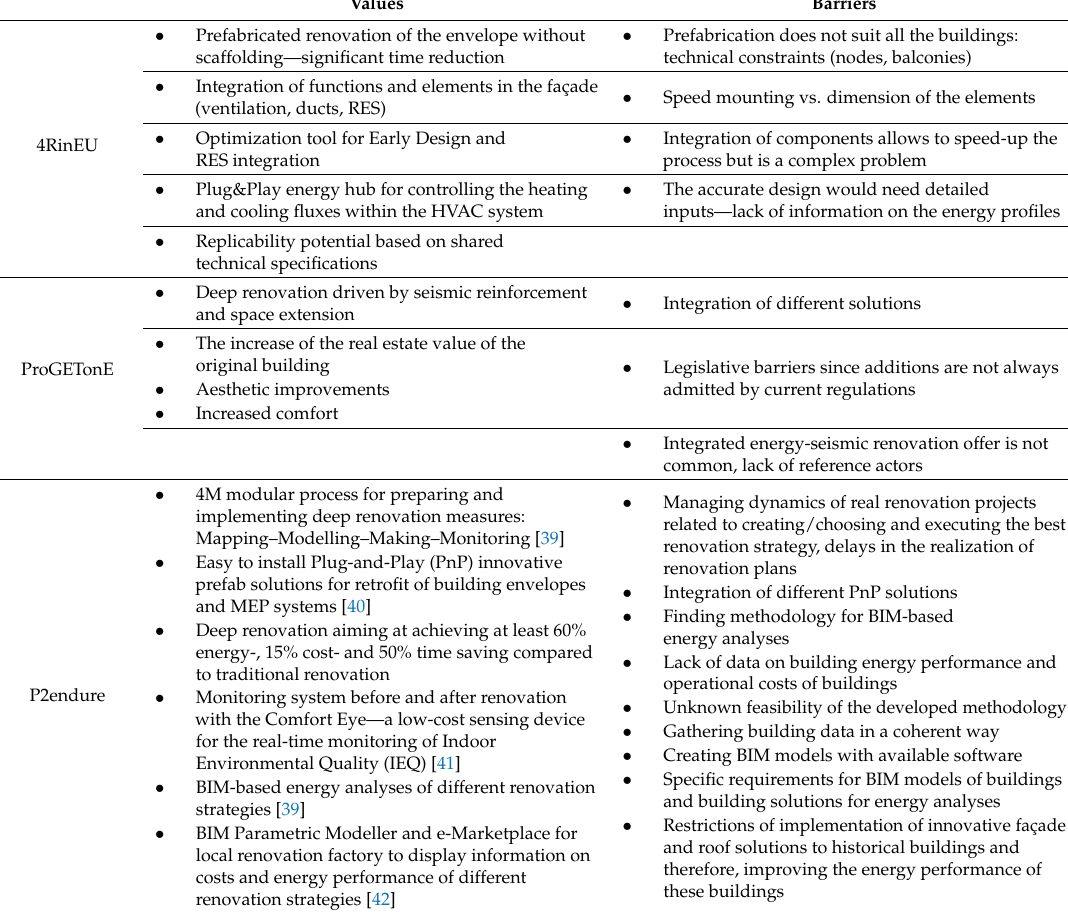
Table 4. Key technical added values and barriers emerged from the 4 Cluster